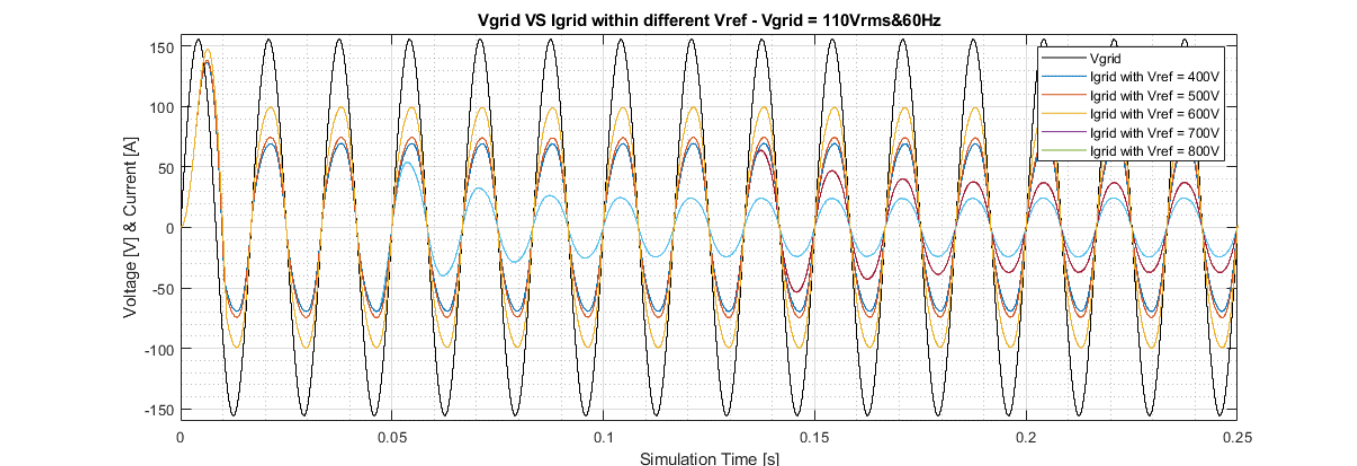
Figure 18. Current control within V ref different scenarios when V grid = 110 Vrms and 60